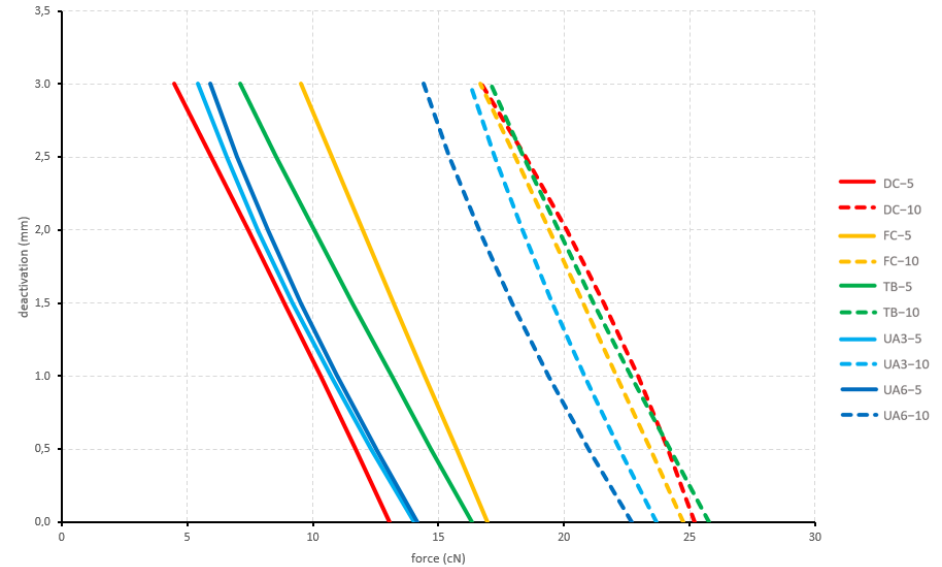
Figure 11. Vertical forces generated by the arch-formed configurations during deactivation. Tested cantilever configurations origin from Figure 2.